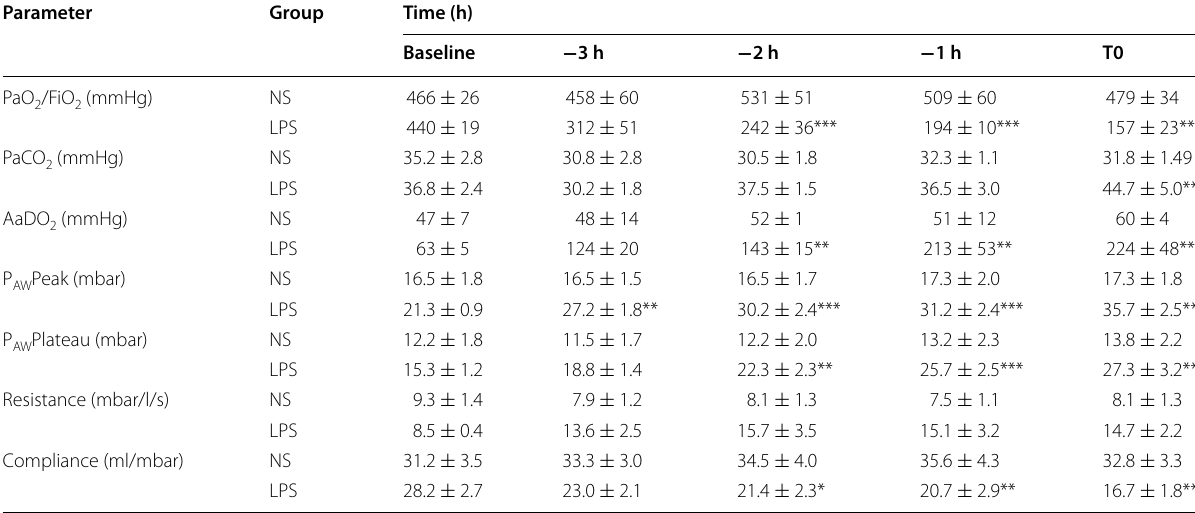
Oxygenation and ventilation parameters in saline control and LPS challenge animals at baseline and a series of time points until the end of the experiment when ALI model was diagnosed (data shown are mean SEM, N 6 of each group; * P < 0.05; ** P < 0.01; *** P < 0.001 versus control group). PaO 2 , oxygen partial pressure; FiO 2 , ± = inspiratory oxygen fraction; PaCO 2 , carbon dioxide partial pressure; P AW Peak, peak airway pressure; P AW Plateau, plateau airway pressure